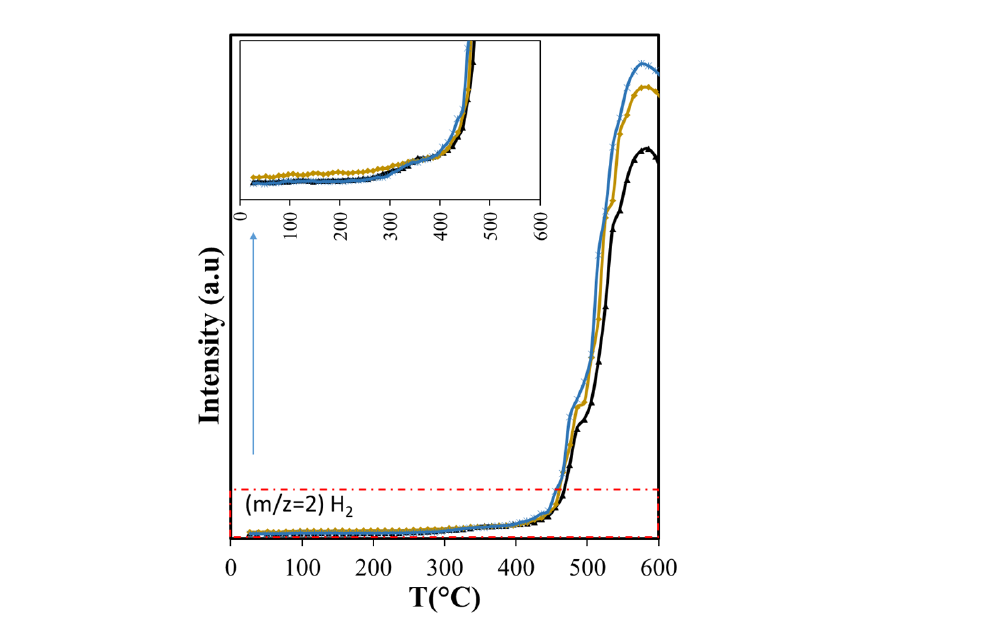
Figure 11. Effects of Aerosil 380 silica and MCM-41 over aromatic compounds produced in catalytic pyrolysis of Agave salmiana bagasse. ( ASB, Aerosil 380, MCM-41).